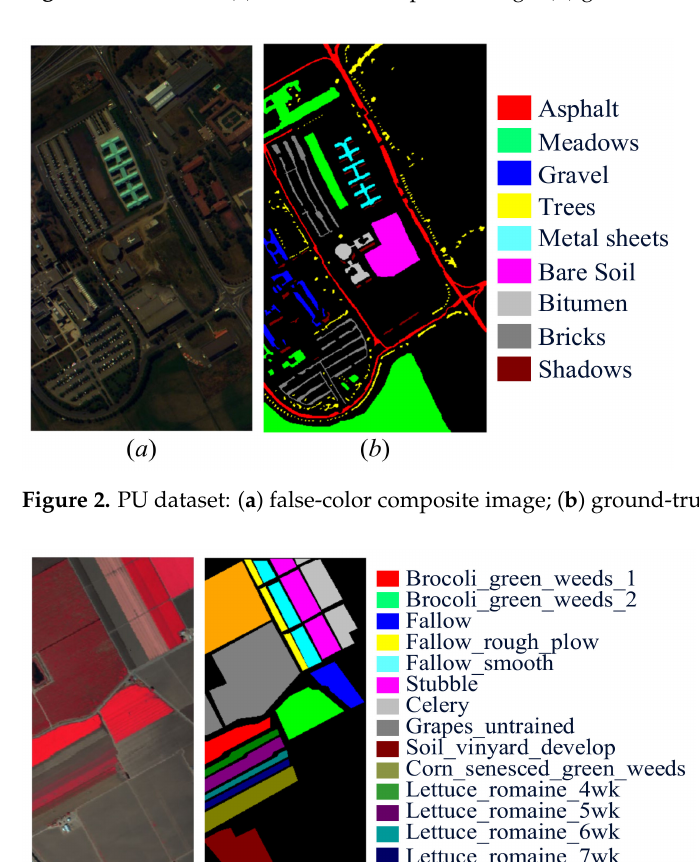
Figure 1. IP dataset: ( a ) false-color composite image; ( b ) ground-truth classes.